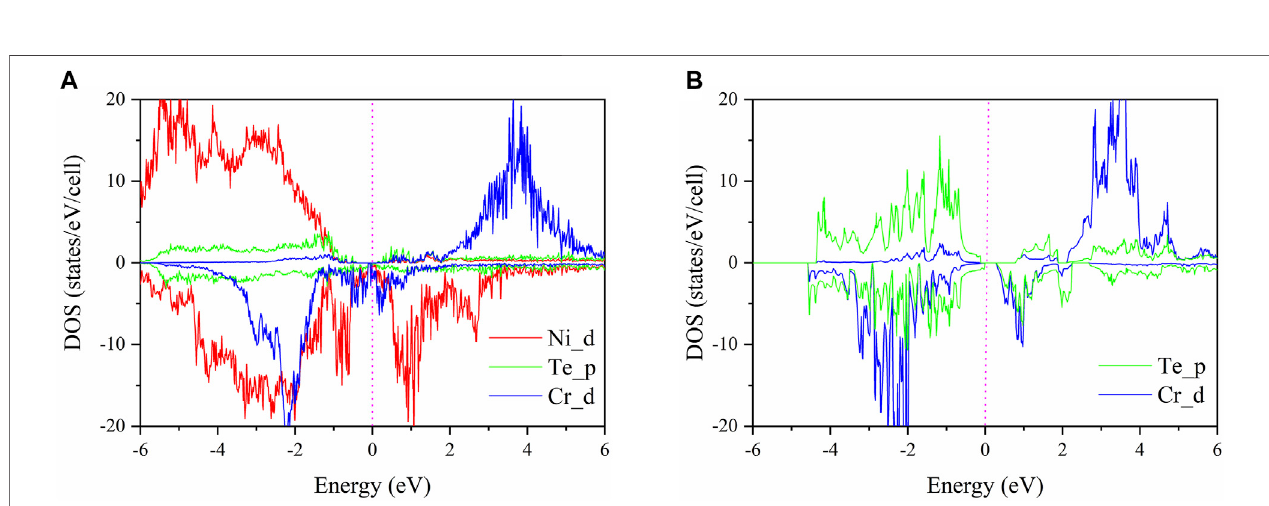
FIGURE 4 | (A) Projected density of states (PDOS) for the CrGeTe 3 /NiO interface in the FM2 state. (B) Projected density of states (PDOS) for CrGeTe 3 alone. The Fermi level is set to zero.